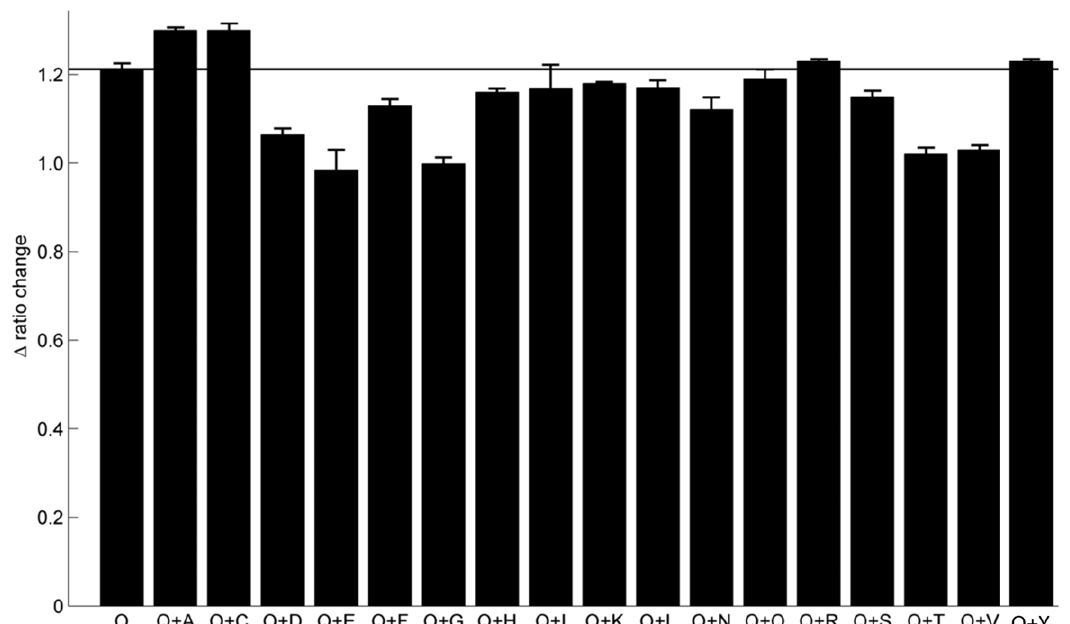
Figure 5. Assessment of the competition of other amino acids for the glutamine binding protein in the glutamine biosensor. The ability of the purified biosensor protein to accurately report the concentration of glutamine in the presence of other amino acids was measured using the maximum intracellular concentration of amino acid encountered during cell culture and 1 mM glutamine. Results are plotted as the change in FRET ratio between each condition and the FRET ratio of the purified biosensor with no ligand present. n=3. Error bars represent one standard deviation of the mean.